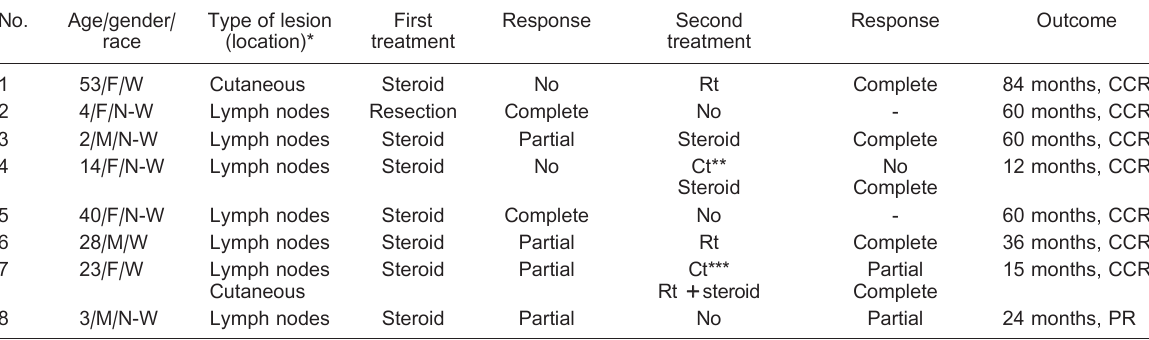
Table 1 . Demographic, clinical characteristics, treatment, and outcome of Rosai-Dorfman patients.